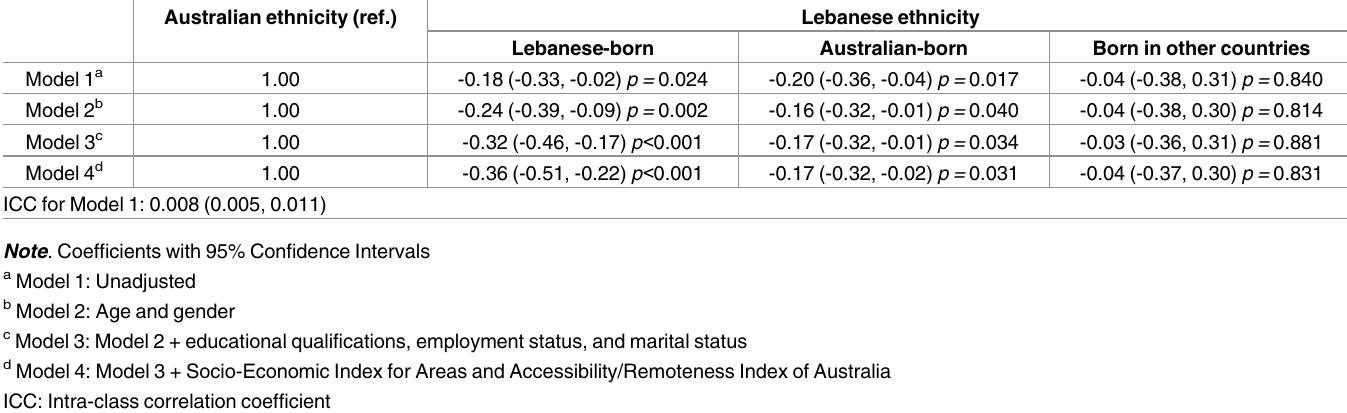
Table 3. Regression coefficients (95% CI) for the lifestyle index score among those of Lebanese ethnicity relative to those of Australian ethnicity. Australian ethnicity